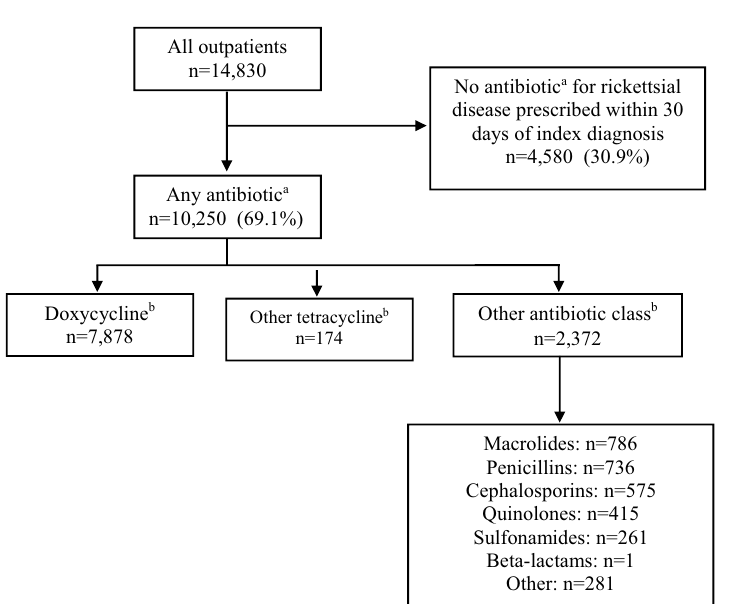
diagnostic group; the lowest was 24.1% for TGR patients, 34.8% for other rickettsial diseases, 54.2% for ehrli- chiosis, and the highest was 61.1% for SFR. Rates also varied considerably across age groups, with only 23.9% of persons < 8 years receiving doxycycline (94.0% of those received it within 14 days of index date), compared